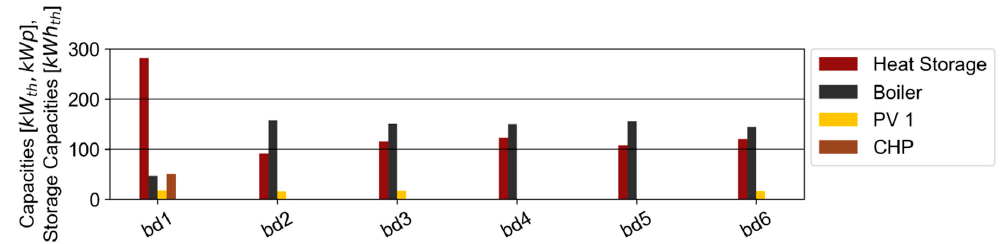
Figure 3. Installed capacities in buildings (bd) for reference case with full-time series.